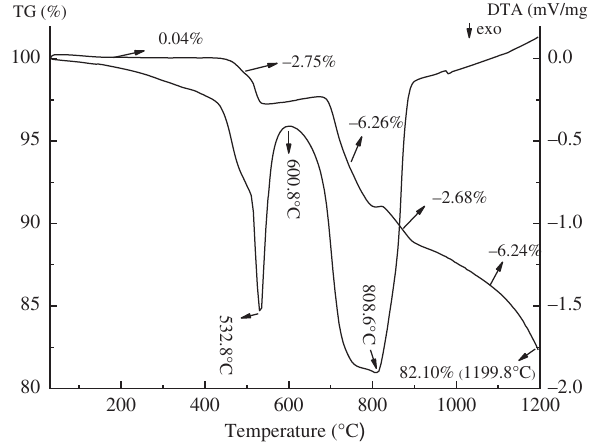
Figure 3: TG-DTA curves of zinc sulfide